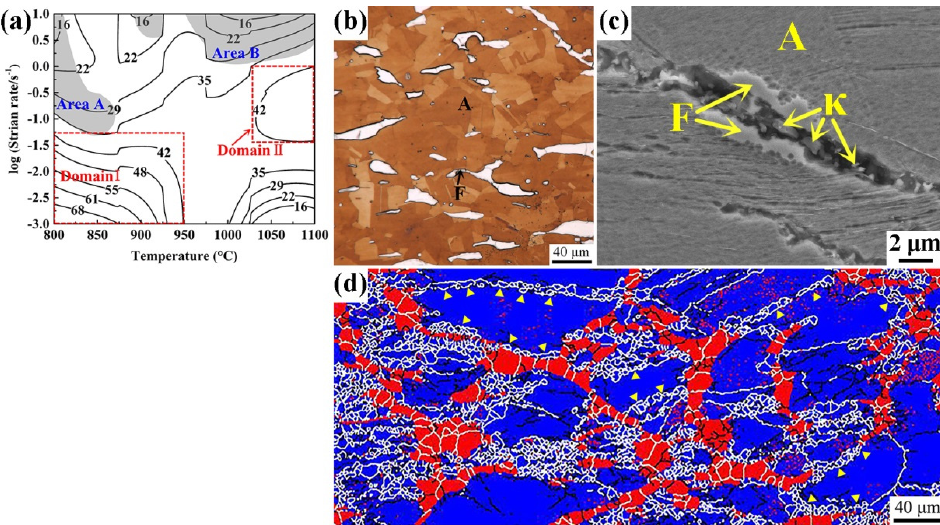
Figure 9. ( a ) The processing map the Fe-11Mn-10Al-0.9C medium-Mn duplex lightweight steel at true strain of 0.7, ( b ) optial image of the specimen deformed at 1100 ◦ C and 0.1 s − 1 corresponding to Domain II showing a fine and uniform DRX microstructure, ( c ) scanning electron micrograph of the specimen deformed at 800 ◦ C and 0.001 s − 1 corresponding to the instable area A showing the micro-crack induced by κ -carbide, and ( d ) the EBSD phase map of the specimen deformed at 1000 ◦ C and 1 s − 1 corresponding to the instable area B showing the necklace structure (A: austenite, F: ferrite, κ : κ -carbide) [182]. (Reproduced with permission from [182]. Copyright 2019 Springer